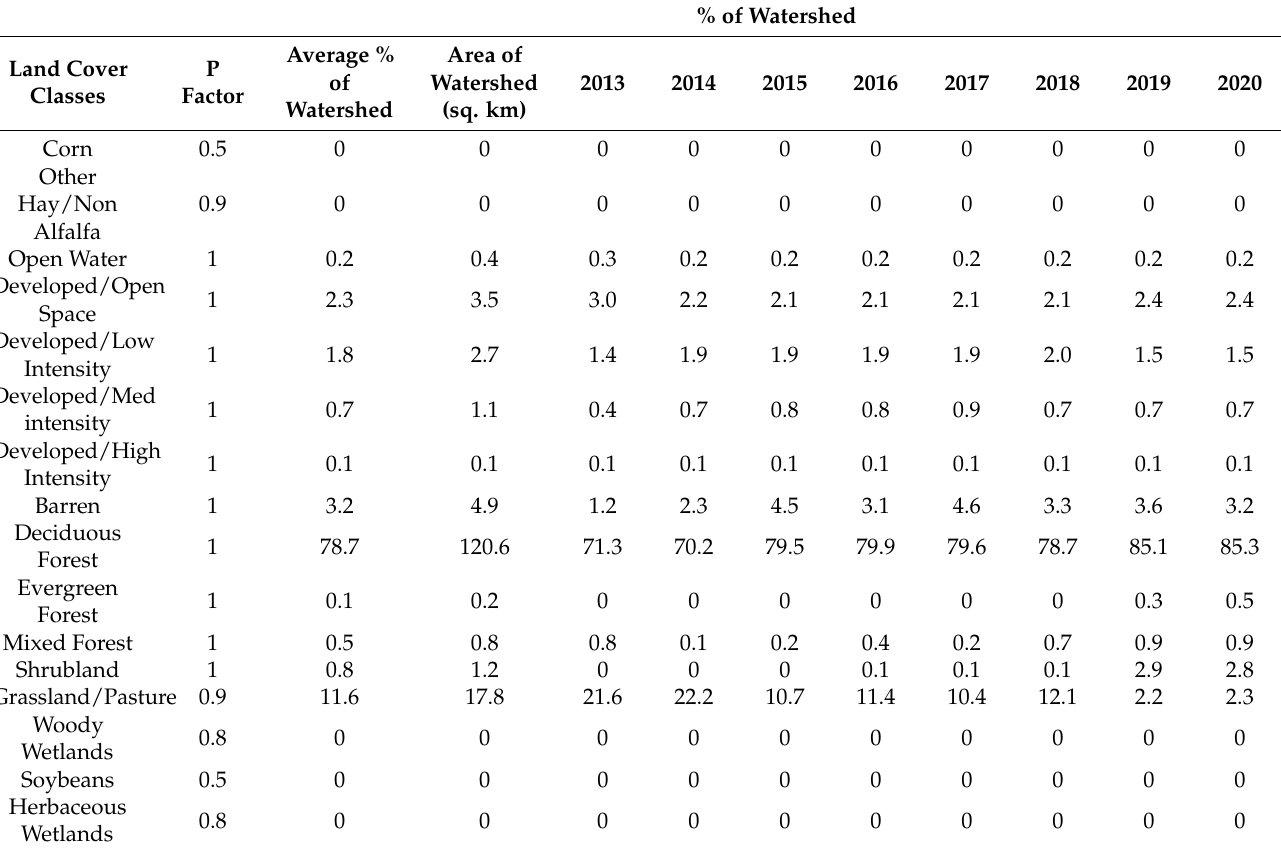
Table 6. Land cover classes with P factor and Area percentage of watershed. % of Watershed